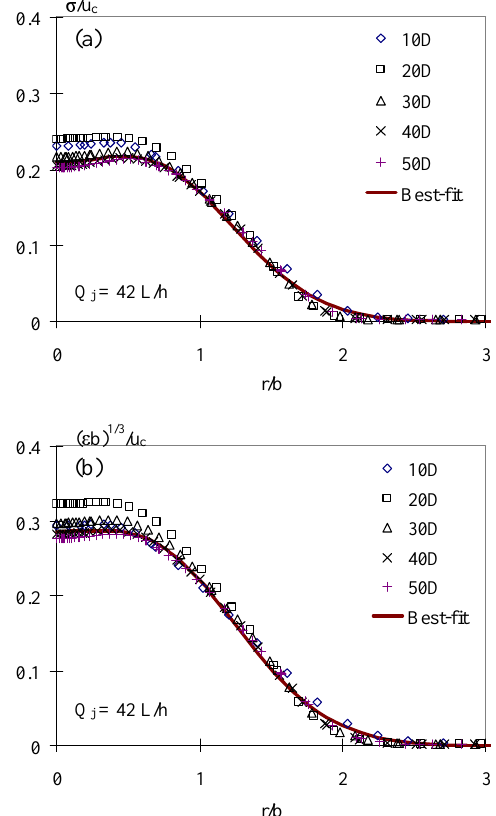
Figure 2. Self-similar turbulent velocity fluctuation and profiles Fig. 2. Turbulent velocity fluctuation and dissipation rate dissipa- rate dissipation, predicted by CFD model (symbols) and fitted with tion, predicted by CFD model (symbol) and fitted with empirical empirical equations (lines), (a) RMS turbulent velocity equations (lines), (a) RMS turbulent velocity fluctuation, Eq. 12, (b) Turbulent energy dissipation rate, Eq. 13.